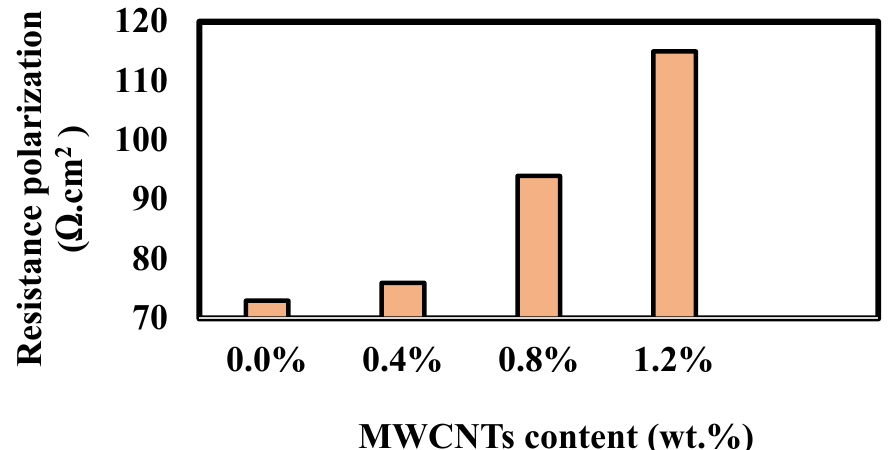
Figure 10. Resistance polarization of Cu-MWCNT nanocomposites. Table 4. The resistance polarization and corrosion rate of Cu reinforced with MWCNTs. Sample